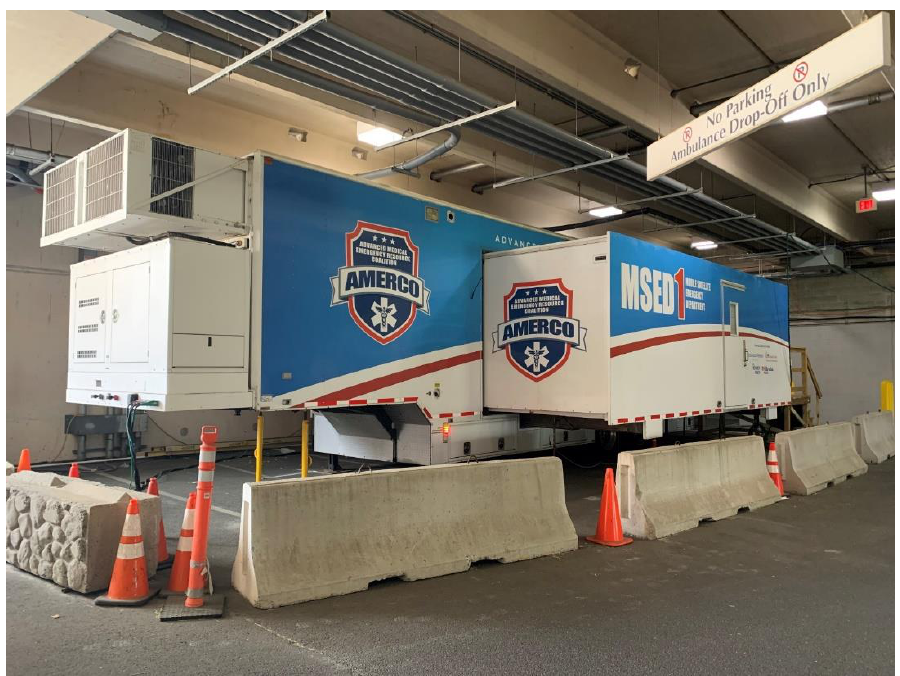
Figure 1. External view MSED outside the Emergency Department. Jersey Shore University Medical Center. Neptune, NJ, USA.